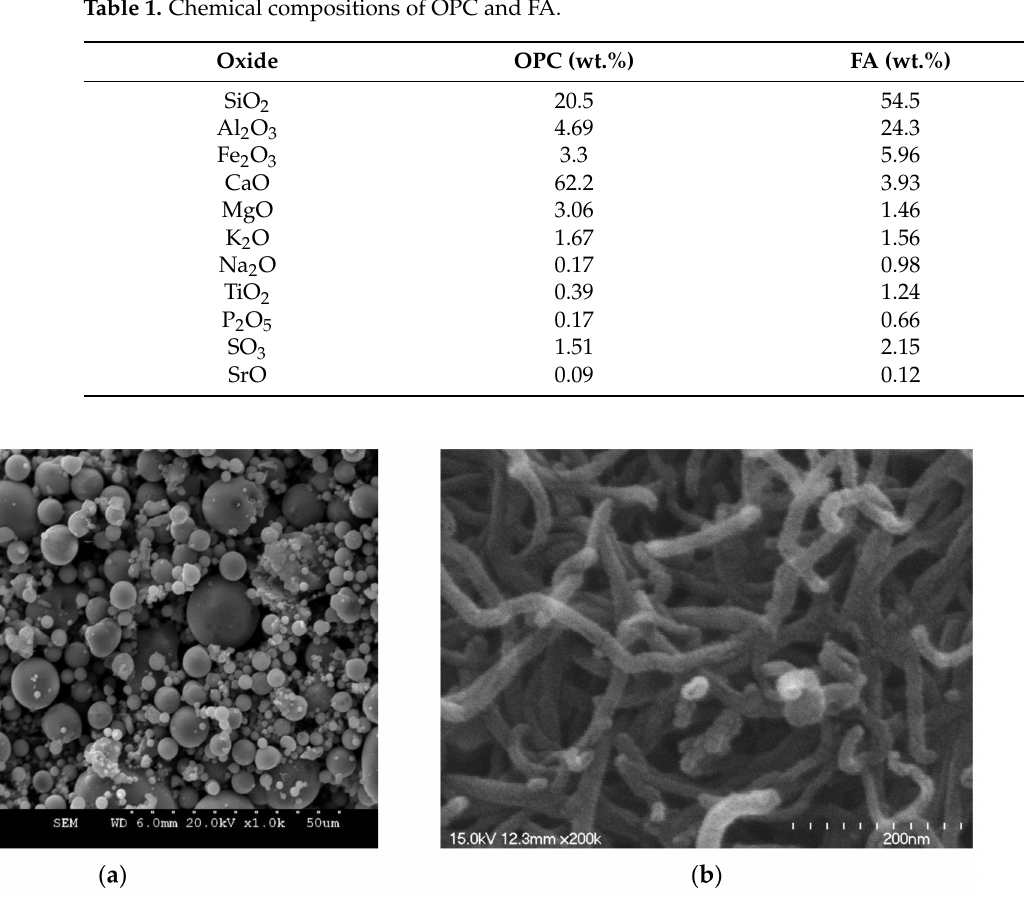
Figure 1. SEM images of raw materials: ( a ) FA; ( b )